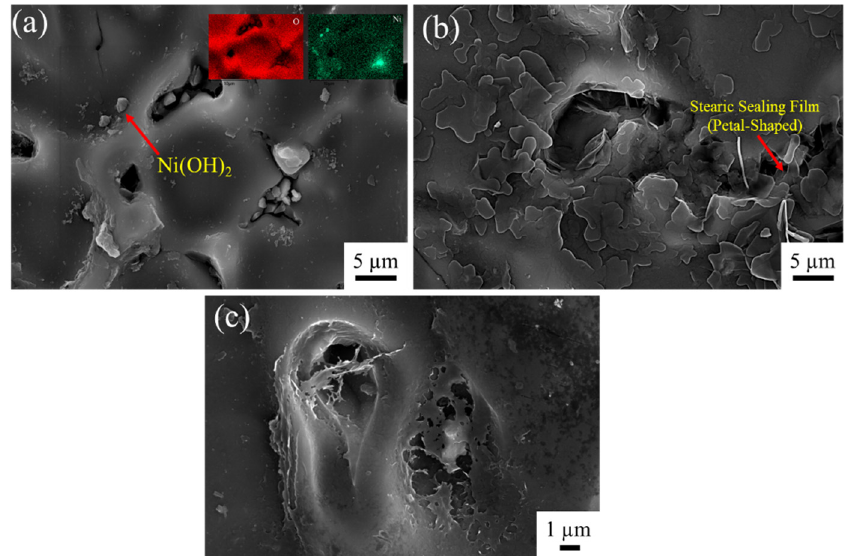
Figure 7. SEM micrograph of the oxide film with sealants showing byproducts and sealing film after sealing with ( a ) nickel fluoride with element mapping of O and Ni in the inset, and ( b ) stearic acid with ( c ) high magnification of sealing film in the voids.